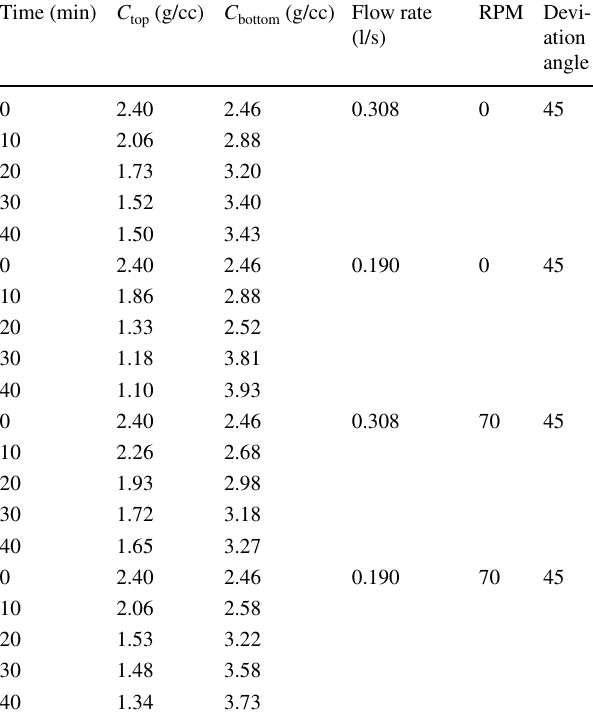
Fig. 2 Drilling mud shear stress change as a function of shear rate Table 4 The results of dynamic investigation under temperature of 38 °C